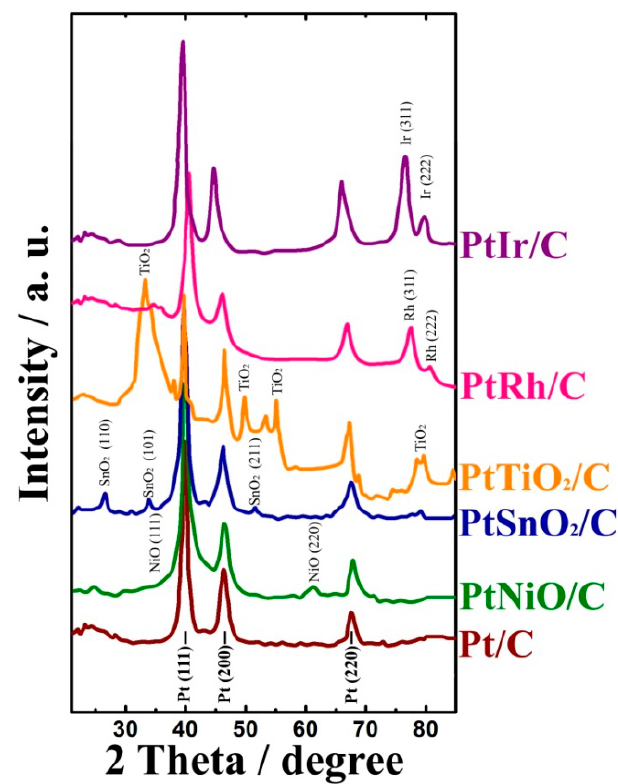
Figure 1. X-ray powder diffraction patterns of the Pt/C, PtNiO/C, PtSnO 2 /C, PtTiO 2 /C, PtRh/C, and PtIr/C catalysts.